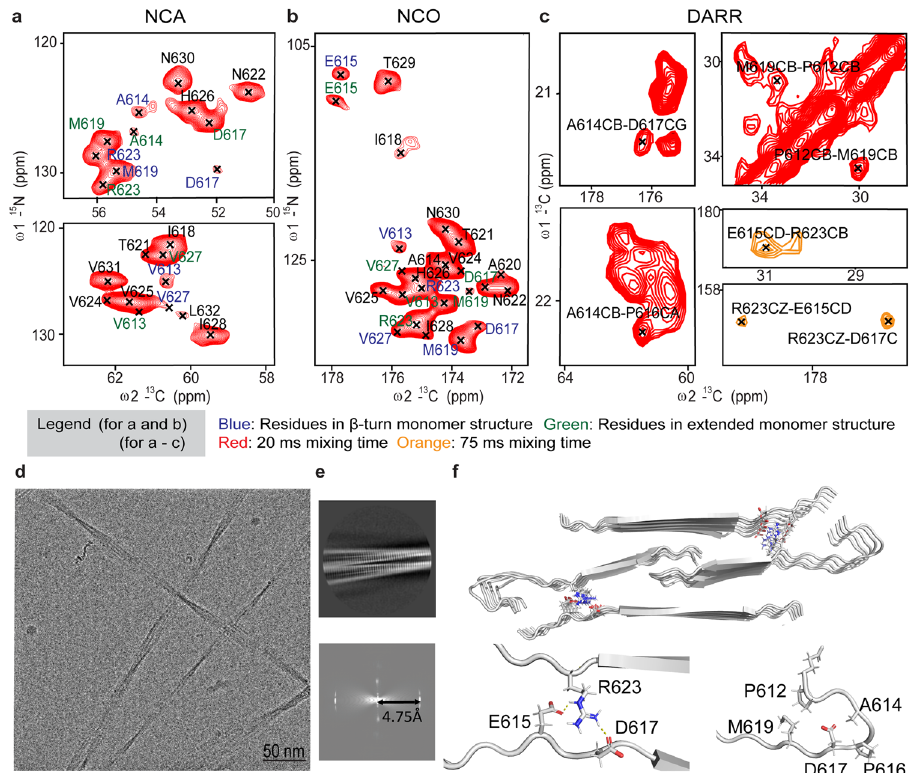
Fig. 1 Atomic model of the G623R fi bril reconstructed using ssNMR and cryo-EM. a 2D NCA and ( b ) 2D NCO (Contour level: 7e + 006, 37, 1.1) ( c ) 2D 13 C- 13 C DARR with contact time 20 ms and 75 ms spectra of the 13 C- 15 N labeled G623R fi bril represented in red and orange, respectively. Residues coming from the extended conformation and β turn regions are colored in blue and green, respectively. (Contour level: 1.5e + 006, 37, 1.1). d Representative cryo- EM image of the G623R fi bril. e 2D class average of the fi bril and its respective power spectrum showing distance between meridian line and 1 st layer line of 4.75 Å. f Calculated model of G623R fi bril comprising 5 repeating units each consisting of 4